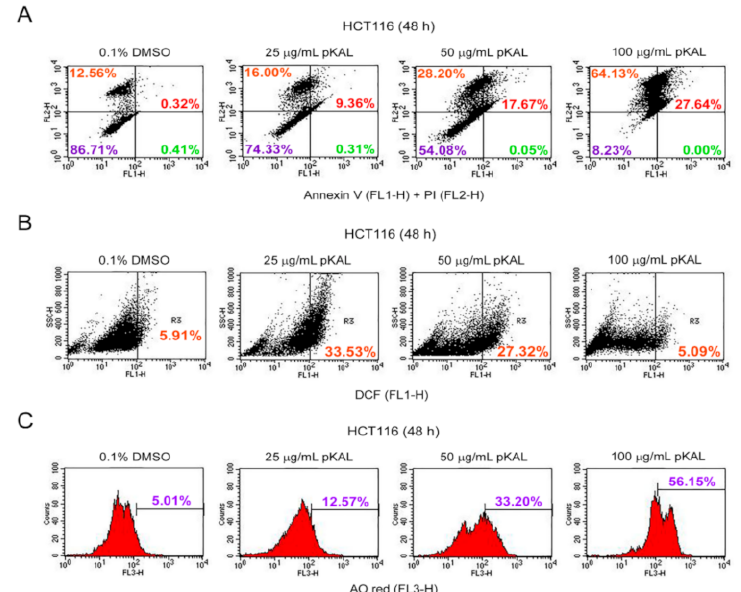
Figure 2. Effect of pKAL on the regulation of propidium iodide (PI) uptake, apoptosis, reactive oxygen species (ROS), and acidic vesicles: HCT116 cells were grown for 48 h with the indicated amount of pKAL. The floating and attached cells were analyzed by flow cytometry: ( A ) co-staining of annexin V (FL1-H) and PI (FL2-H), ( B ) dichlorofluorescein (DCF) (FL1-H) staining, and ( C ) acridine orange (AO) red (FL3-H)